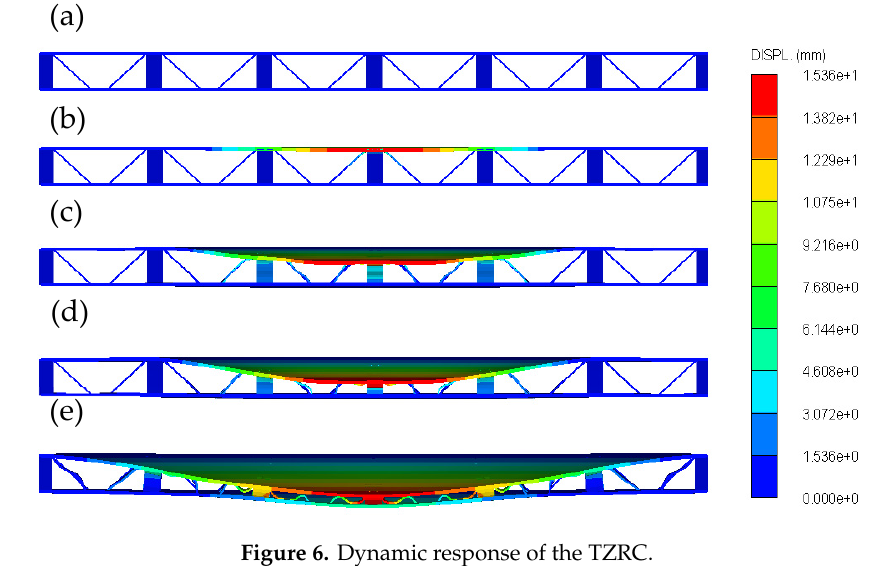
Figure 5. Schematic and inner core configuration of the ribbon core sandwich structures. ( a ) Trapezoidal corrugated ribbon core (TZRC)-panel. ( b ) Triangular ribbon corrugated core (TRC)- panel. Previous studies [14] revealed that the behavior of the sandwich structure subjected to blast load can be split into three stages, namely the fluid–structure interaction stage, core compression stage, and structural dynamic response stage. Figure 5 shows a series of deformation processes of TZRC and TRC panels subjected to the detonation of 55 g TNT with a stand-off distance of 100 mm. Figure 6 and Figure 7a show the panel at time t = 0 after remapping the final state of the 2D model to a 3D model just before the impulse is imparted to the front-face sheet of the sandwich panel. Then, at t = 0.001 msec, the shock wave firstly strikes the center of the front-face sheet. From this moment on, the front face was starting to interact with the explosive product. During the fluid–structure interaction stage, the front face obtained an initial velocity when the shock wave impinged on it, while the core and back face kept still. A dent deformation was first formed in the central area of the front face, Figure 6 and Figure 7b. Then, the high compression velocity generated by the front face induced a shock wave into the core and the core would be compressed gradually at t = 0.03 msec. It could be